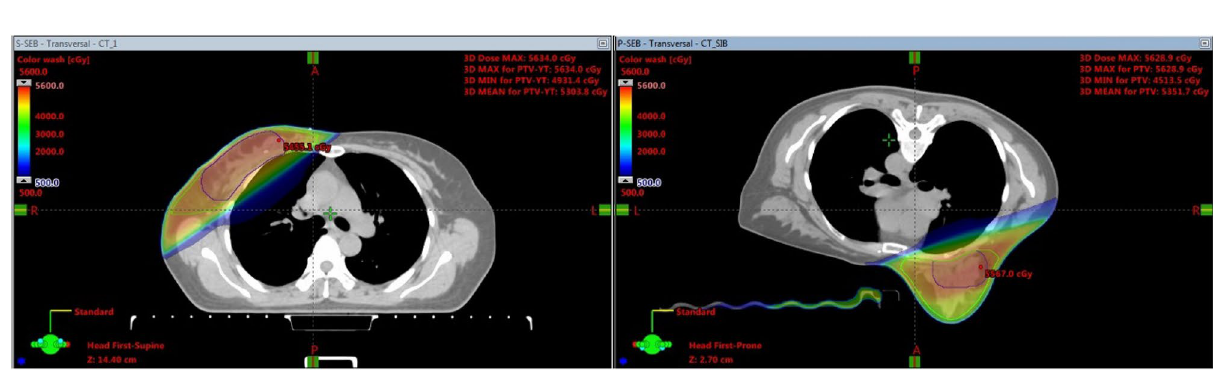
Figure 1. The picture of target volumes and isodose distribution based on supine and prone position for SIB- HFWBI.